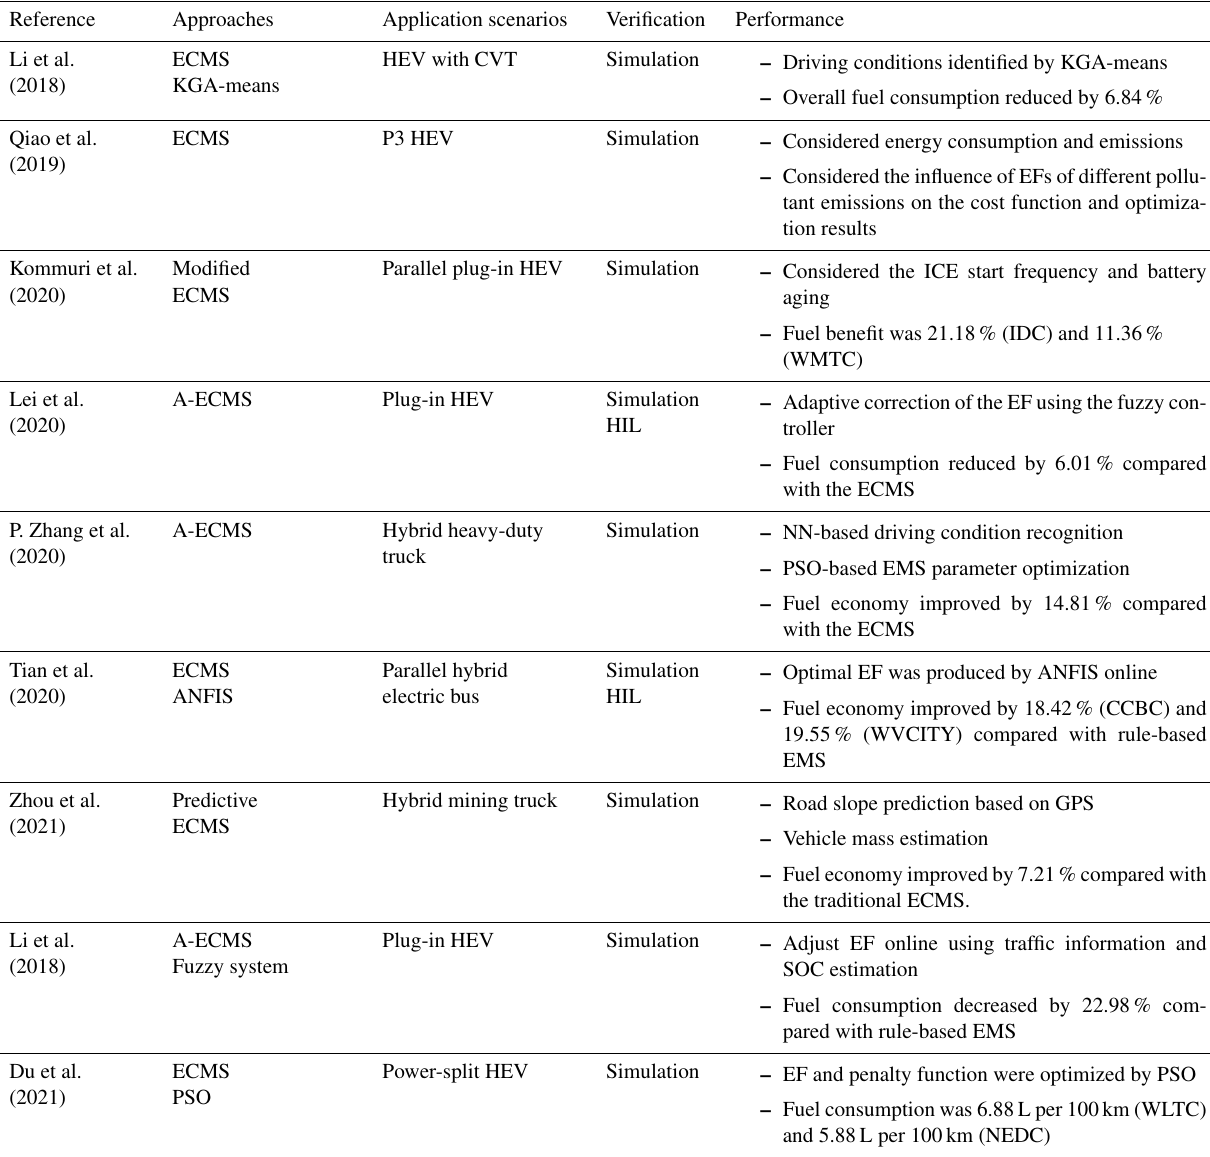
Table 11. Summary of exemplary works on ECMS-based EMSs